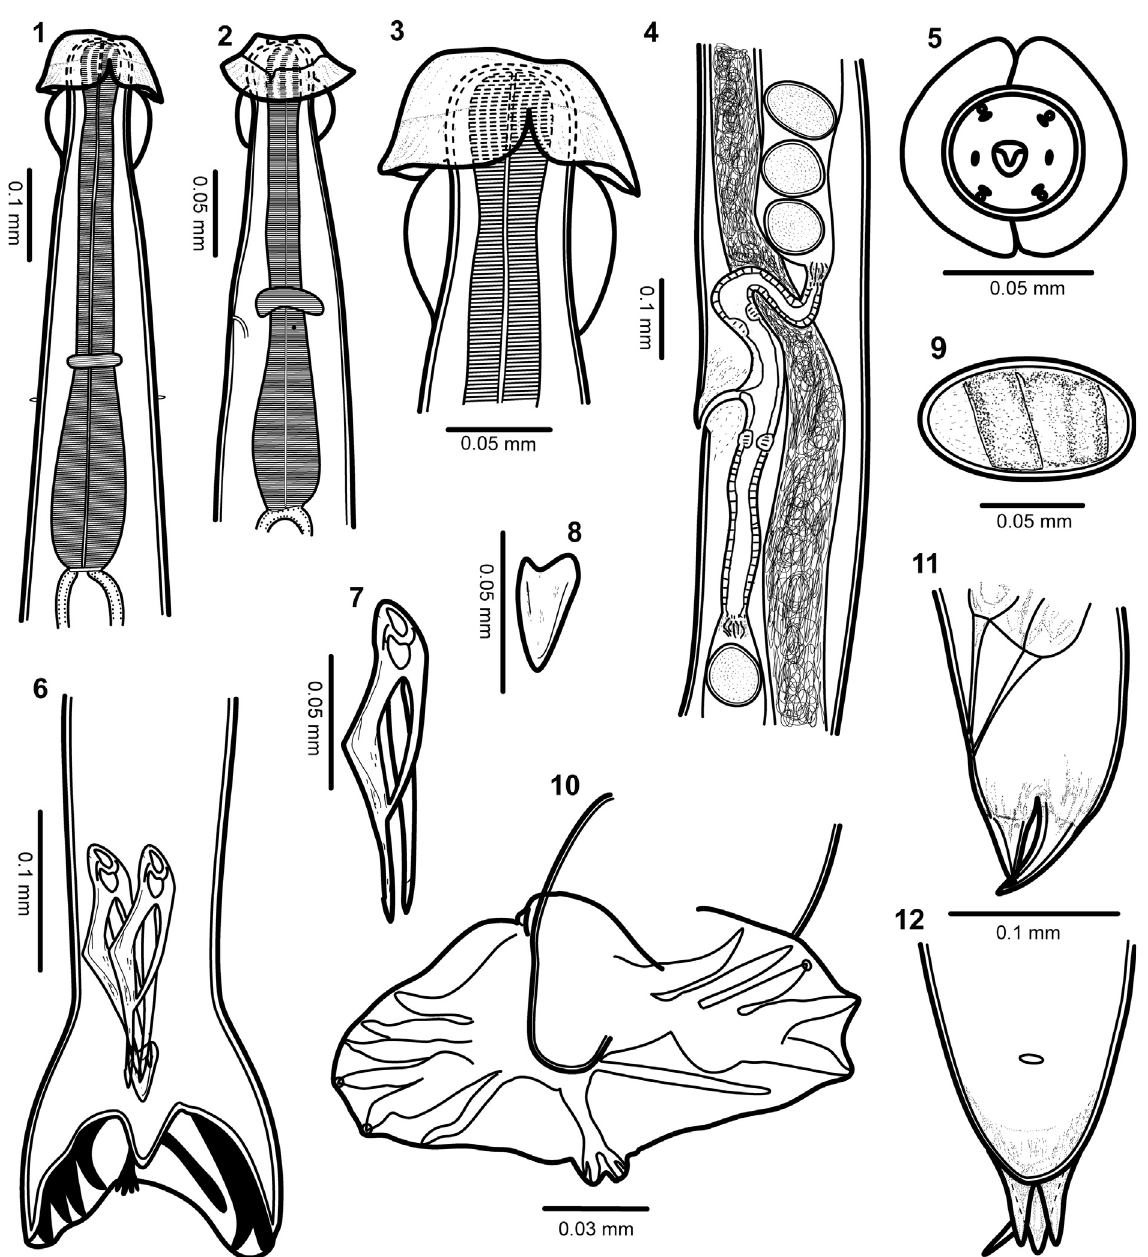
Figures 1–12. Torrestrongylus tetradorsalis n. sp. 1: Anterior end of male, ventral view, showing the esophagus and the relative positions of the nerve ring and deirids; note separation of cuticular projection in anterior vesicle. 2: Anterior end of female, lateral view showing the relative position of the nerve ring, deirid, and excretory pore; note continuous cuticular expansion in anterior vesicle. 3: Detail of the cephalic vesicle showing the anterior half with the lateral projections forming an umbrella and the posterior half with ‘‘handles of a pitcher’’ appearance. 4: Ovejector of female showing flap in anterior lip of vulva, vagina vera, infundibulum, sphincters, and uterine branches containing mature eggs. 5: Face view of male, showing arrangement of papillae and cuticular expansions of the anterior cephalic vesicle. 6: Posterior end of male, showing the relative position of spicules and gubernaculum. 7: Spicule. 8: Gubernaculum. 9: Egg. 10: Caudal bursa showing bursal arrangement and bifurcation of dorsal ray. 11: Lateral view of tail of female. 12: Ventral view of tail of